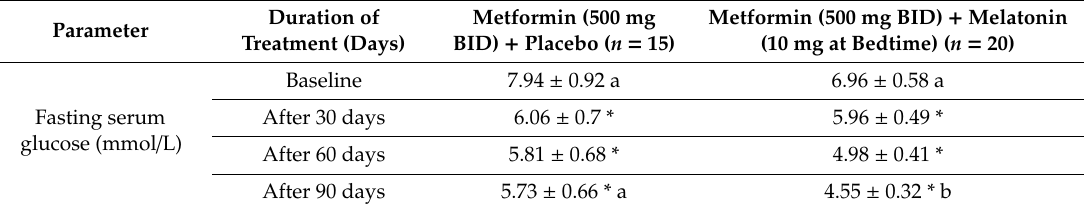
Table 1. E ff ect of treatment with metformin–melatonin versus metformin–placebo on fasting serum glucose level in metabolic syndrome (MEBS) patients.